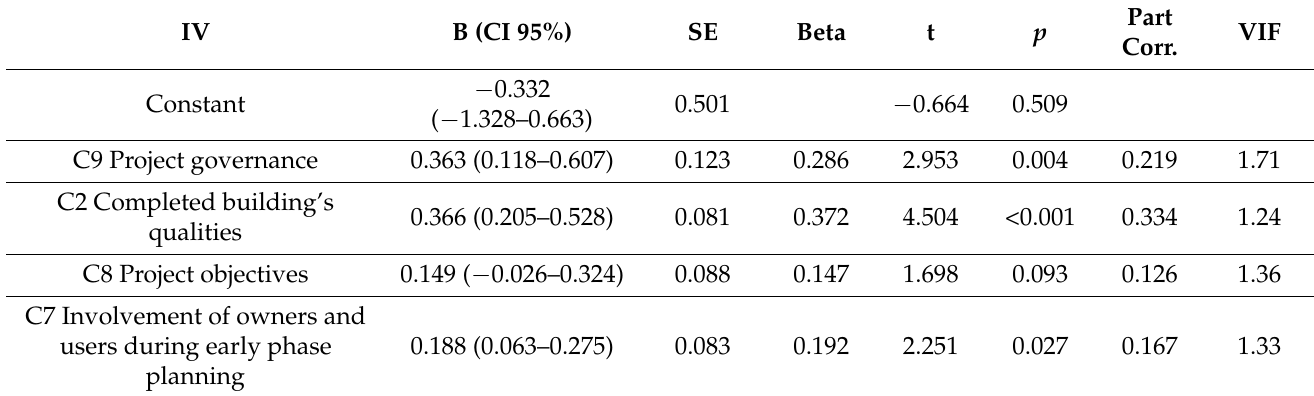
Table 8. Multiple regression with C1 Project outcome as dependent